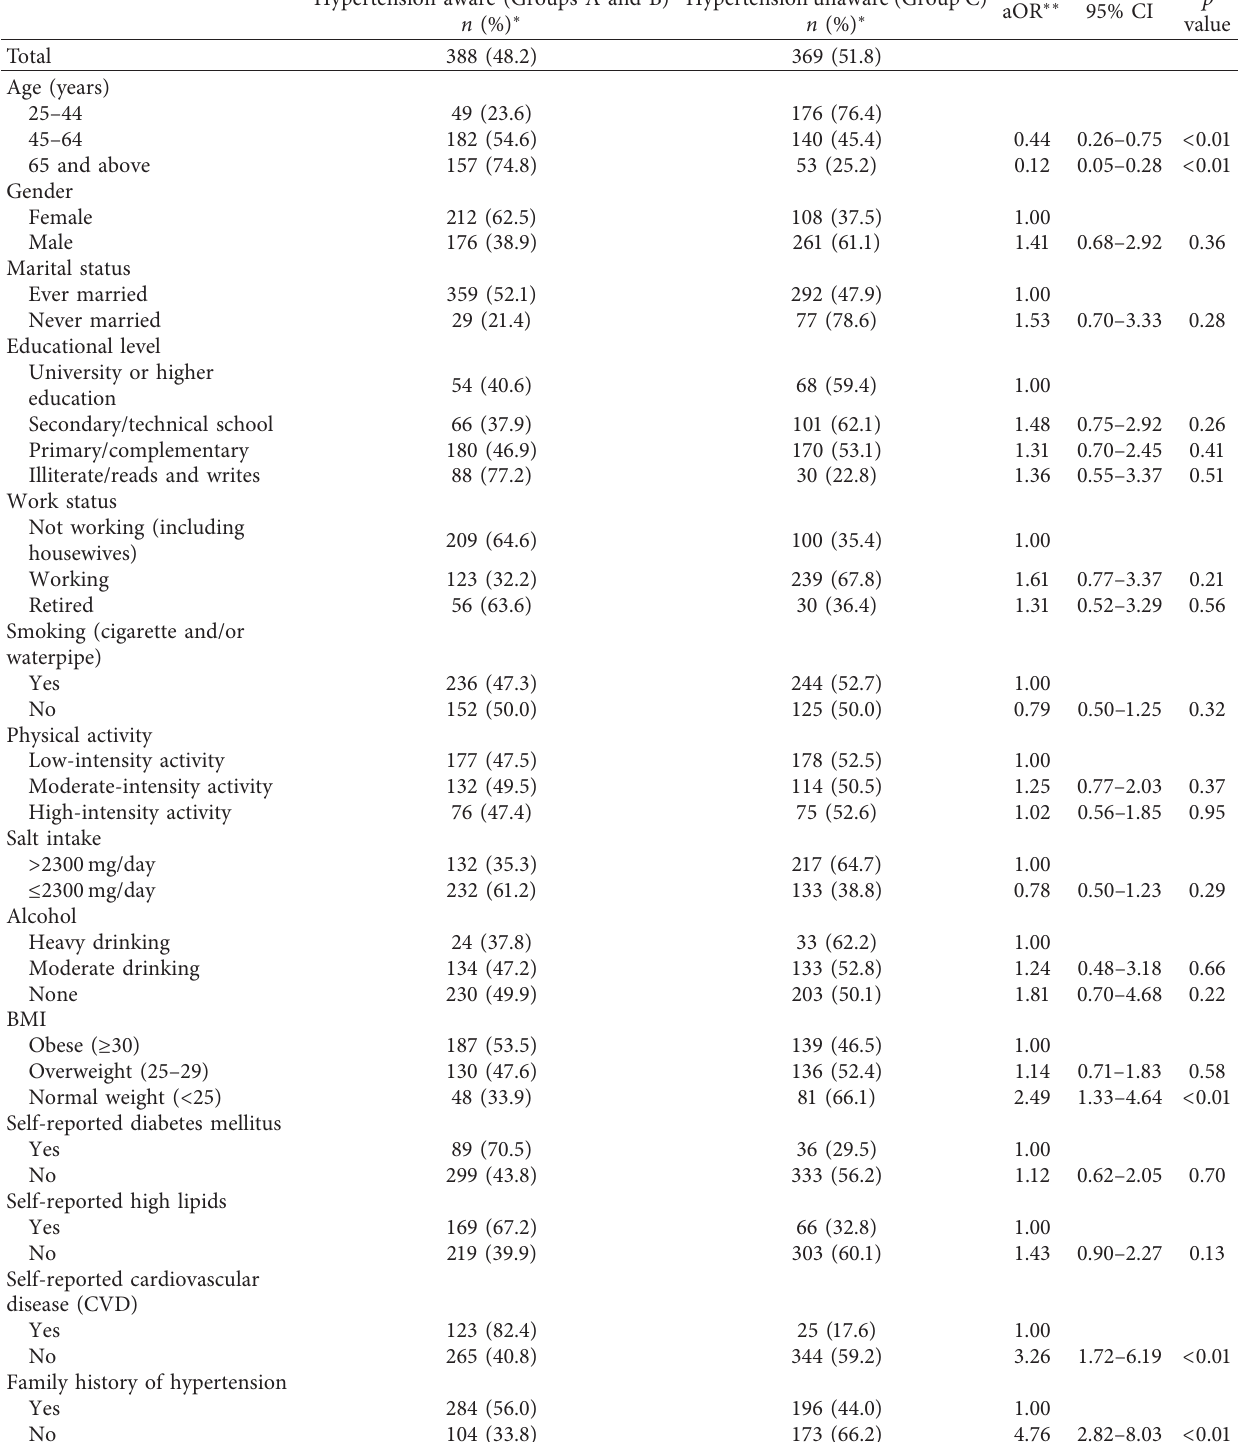
Table 4: Socioeconomic and health characteristics among hypertensives: comparison of hypertension unaware group with hypertension